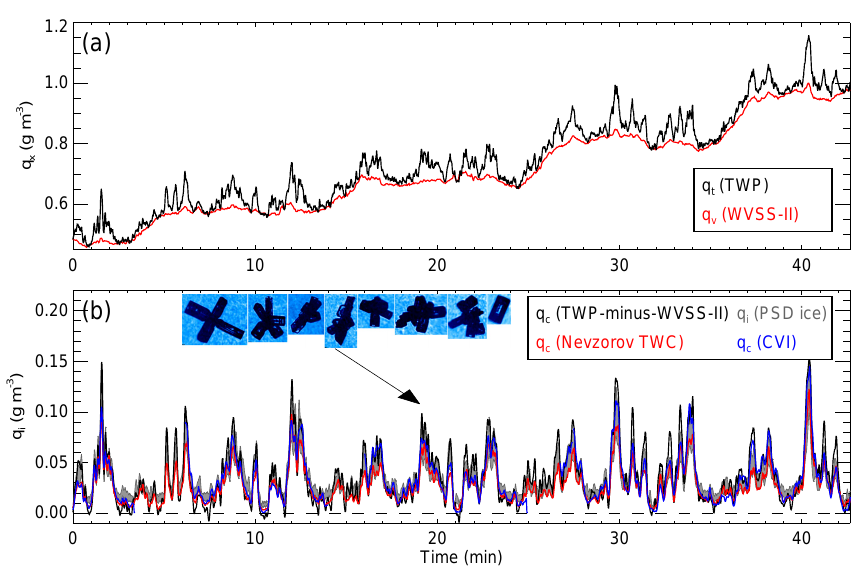
Figure 4. Example data from a race-track descent made in cirrus cloud during flight B672 between temperatures of − 27 and − 19 ◦ C. Panel (a) shows the measured q t from the total water probe and q v from the WVSS-II instrument. Panel (b) shows the q i from the Nevzorov q c sensor, data from the TWP-minus-WVSS-II method and data from the CVI. The grey shading shows a range of q i estimates from the integration of the measured PSD using a selection of M – D relations for ice (see Table 1). Example CPI imagery is also shown.